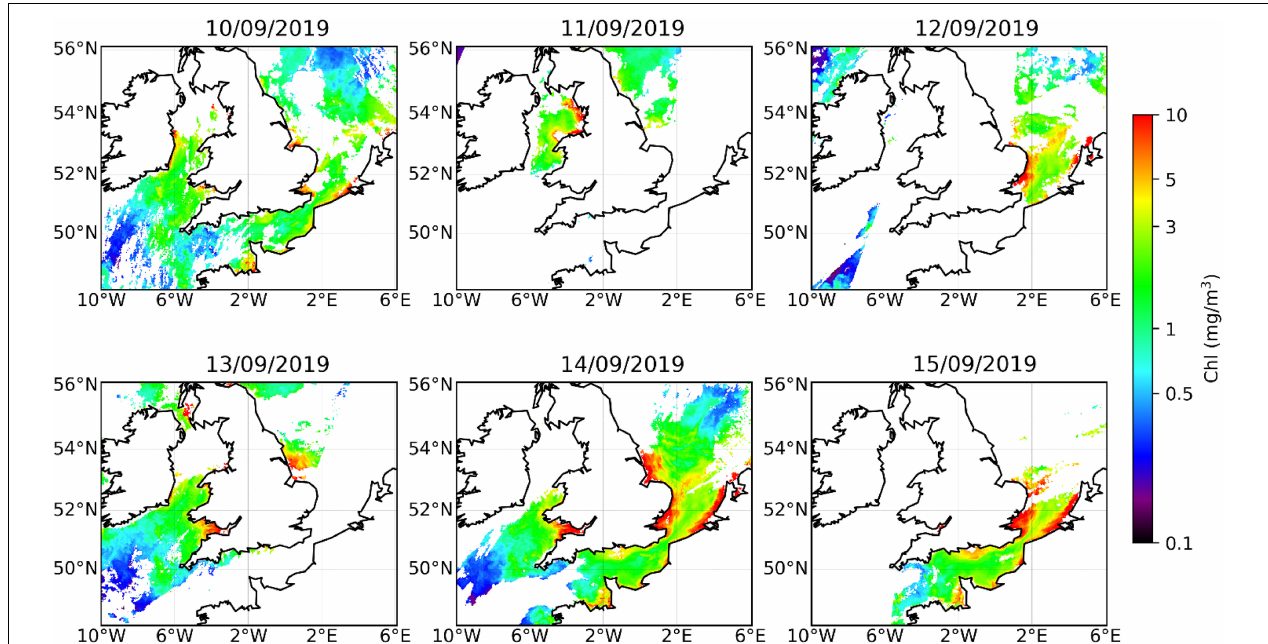
FIGURE 3 | Maps of chlorophyll-a concentration (Sentinel-3 OLCI Level-3 products) during the days with ocean color observations used for prediction of HABs (or other bio-optical parameters).